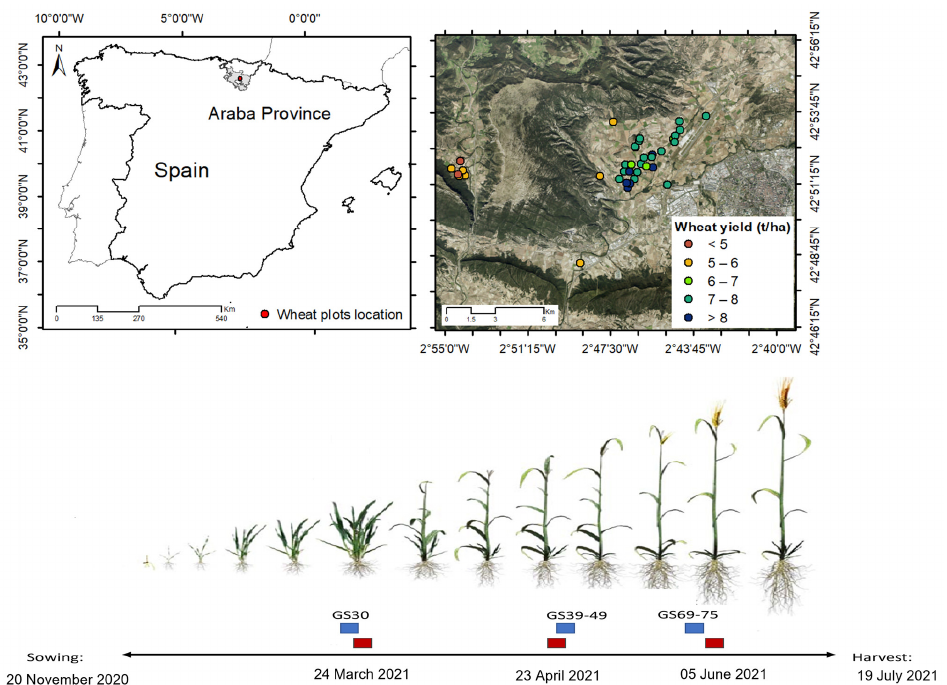
Figure 1. Upper left-hand side of the image shows the general location of the study area within Spain. Upper right-hand side shows detail of the study area with the average yield of each plot (right part). Below, wheat phenological stage and dates when satellite images were acquired. Red squares represent S1 and blue squares represent S2. According to the Köppen classification, the Llanada Alavesa region has a temperate oceanic climate (Cfb) [59] characterized by an average annual air temperature of 11.7 °C. During the summer months, the average temperature reaches 20 °C, while the winter months are relatively mild with an average temperature of 6 °C. Average annual rainfall was 750 mm, with July and August being the driest months with less than 50 mm of pre- cipitation. The study plots were established over two distinct soil types developed on two different lithologies. Thus, soils on the lithology from the Cretaceous geological era are characterized by steep and irregular terrain, are relatively shallow (20–70 cm), and have a high concentration of calcium carbonate (CaCO 3 ) of over 50%. The dominant soil fraction is silt, which has a concentration exceeding 40%. The second type of soil, sourced from Quaternary material, is deeper (over 120 cm), has a lower concentration of CaCO 3 (<25%) and a loamier texture, and the stone content is higher [60]. The average grain yield of the studied plots (Figure 1) ranged from 4.76 t ha −1 for the G32 plot to 8.91 for the G7 plot, with an average value for all plots of 7.01 t ha −1 . Plot size ranged from 0.72 to 9.42 ha, with 2.46 ha being the average, representing well Llanada Alaves’s plot diversity.